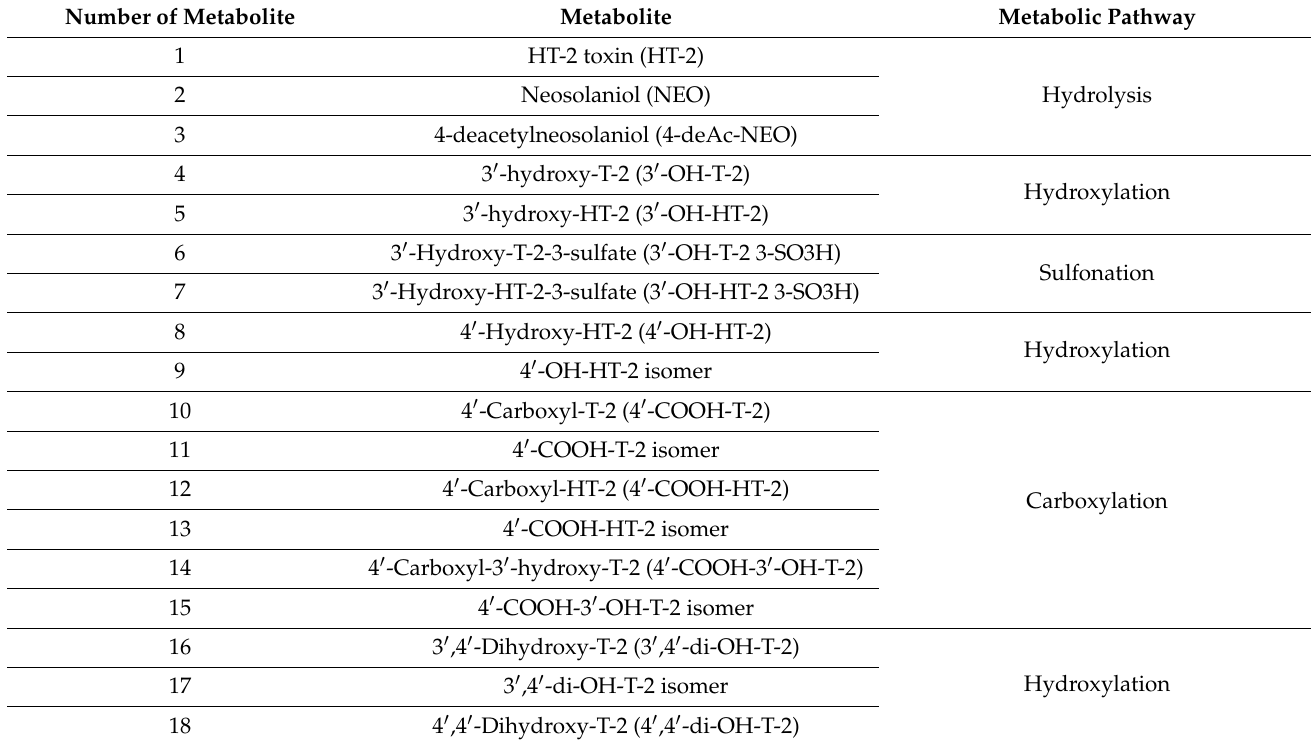
Table 2. Summary of T-2 toxin metabolites in in vivo study in